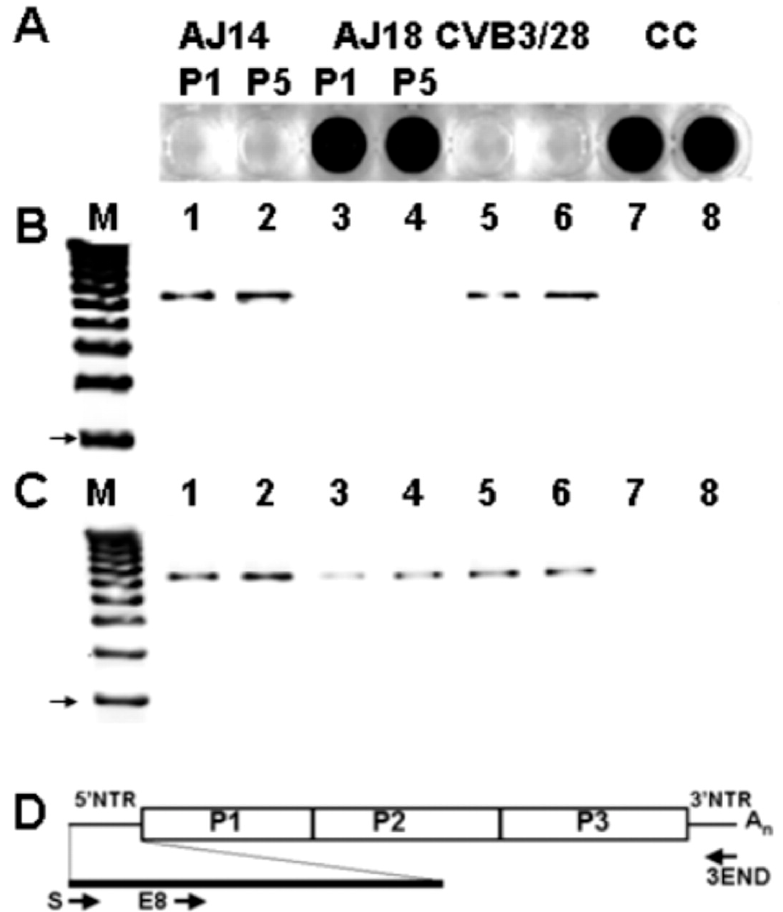
Figure 1. Infection of HeLa cells with homogenate of CVB3-infected AJ heart at day 18 does not induce cytopathic effect, but does replicate CVB3 RNA. ( A ) HeLa cultures inoculated with homogenates of hearts at days 14 p.i. (AJ14) and 18 p.i. (AJ18) passed once (P1) and five times (P5) in HeLa inoculated with parental virus (CVB3/28) or uninfected cell culture (CC). Cells were stained with crystal violet. ( B , C ) Total RNA purified from HeLa-passaged AJ14, AJ18, CVB3/28-inoculated HeLa cells, and uninfected cells was used for RT-PCR with the primer 3END and with primers S ( B ) or E8 (C). The arrow indicates a 3 kb band. Lane M, 1 kb DNA ladder; lanes 1 and 2, AJ14 P1 and P5, respectively; lanes 3 and 4, AJ18 P1 and P5, respectively; lanes 5 and 6, CVB3/28; lanes 7 and 8, uninfected cell culture. ( D ) Relative positions in the CVB3 genome of primers used. Reproduced with permission from [50] 2005, American Society for Microbiology.